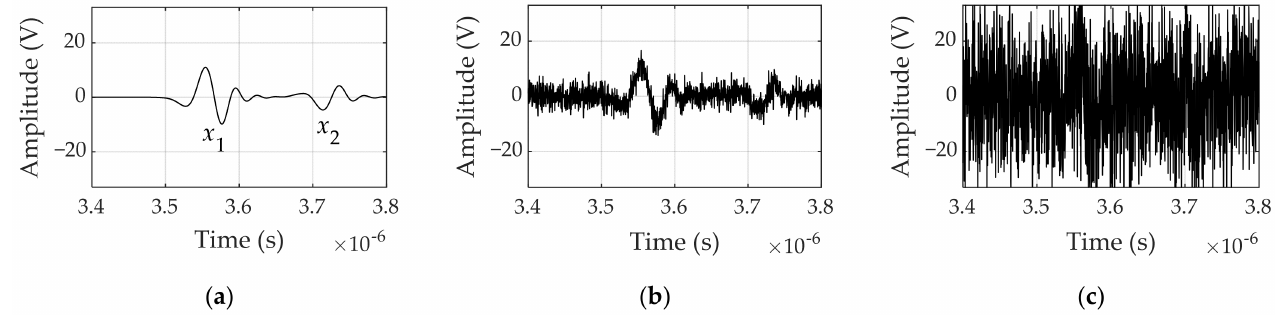
Figure 8. AMI signals with different signal-to-noise ratios (SNR): ( a ) SNR = + ∞ ; ( b ) SNR = 0 dB; ( c ) SNR = − 15 dB.